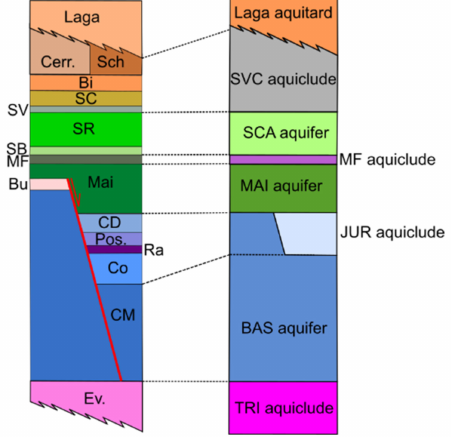
Figure 1. Sketch of relationships between the simplified stratigraphy ( left ) and hydrogeological com- plexes ( right ) (not in scale, modified from [46]. Legend of simplified stratigraphy (name,